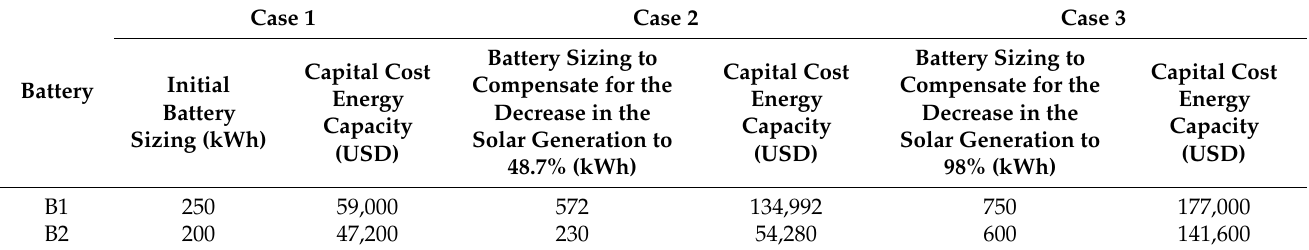
Table 4. Optimal sizing of the batteries when the solar generation forecast changes.